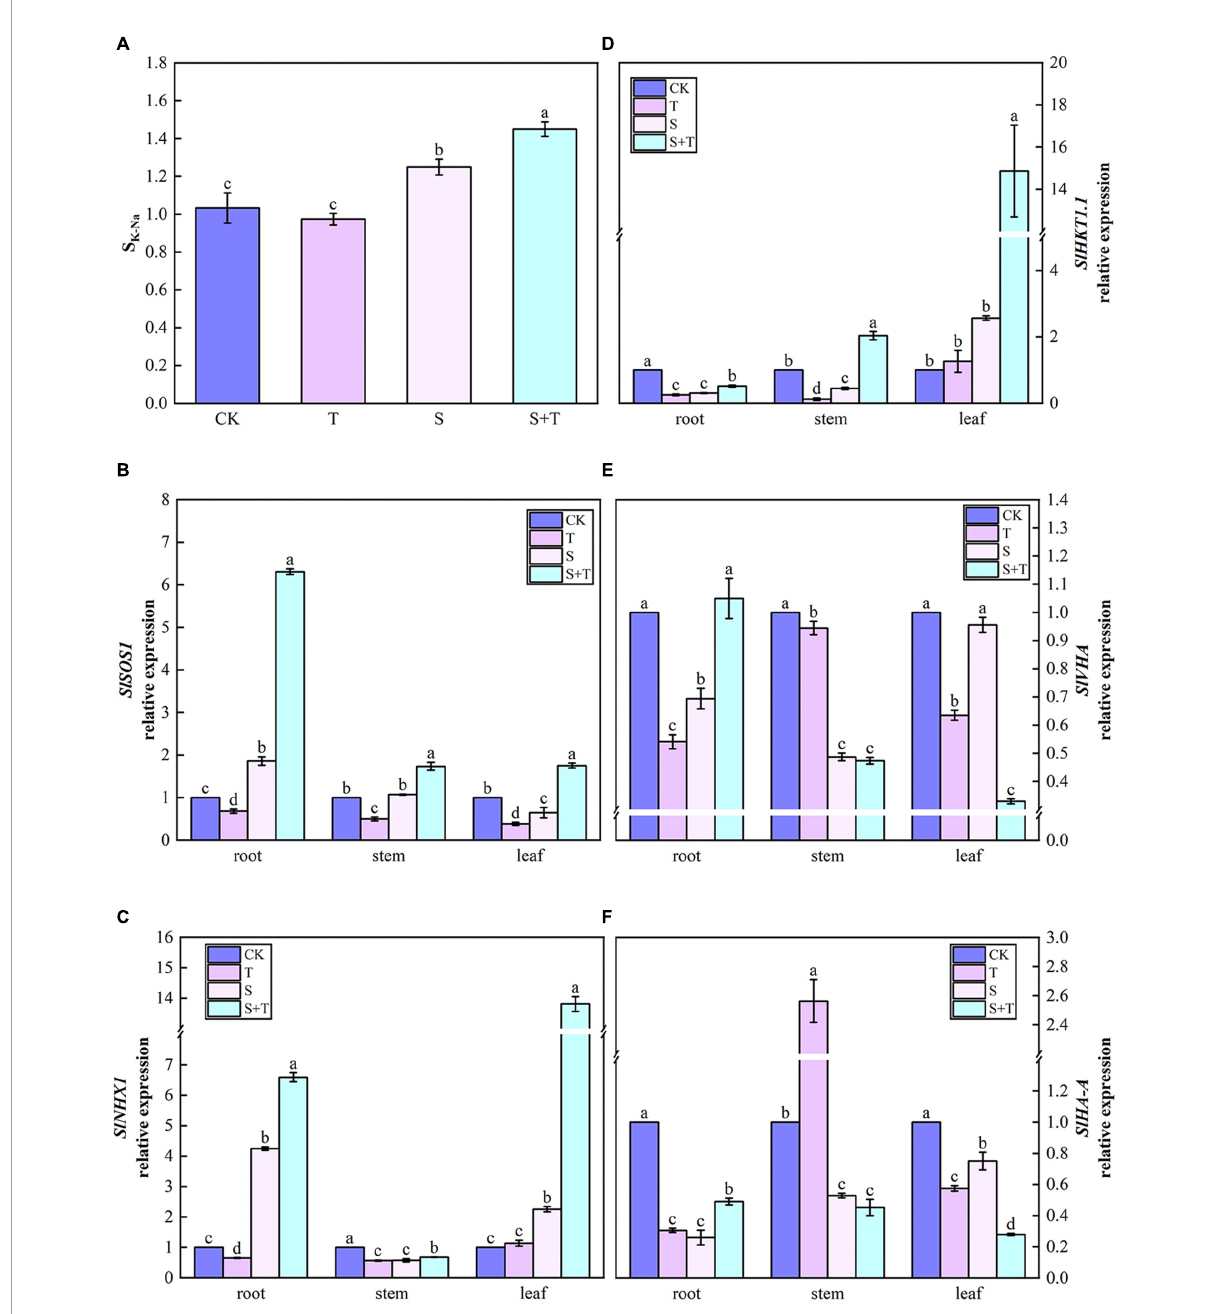
FIGURE10 Effects of Tre treatment on the K-Na transport selectivity ratio and the relative expression of ion transport genes in tomato seedlings under salt stress for 5 days. Panel (A) represents the K-Na transport selectivity ratio (S K − Na ); Panels (B–F) represent the expression levels of SlSOS1 , SlNHX1 , SlHKT1.1 , SlVHA, and SlHA-A , respectively. The results showed the mean ± SE of three replicates, and the different letters denote the significant difference among treatments ( P < 0.05), according to Duncan’s multiple tests. CK, control; T, 10 mM Tre; S, 150 mM NaCl; S + T, 150 mM NaCl + 10 mM